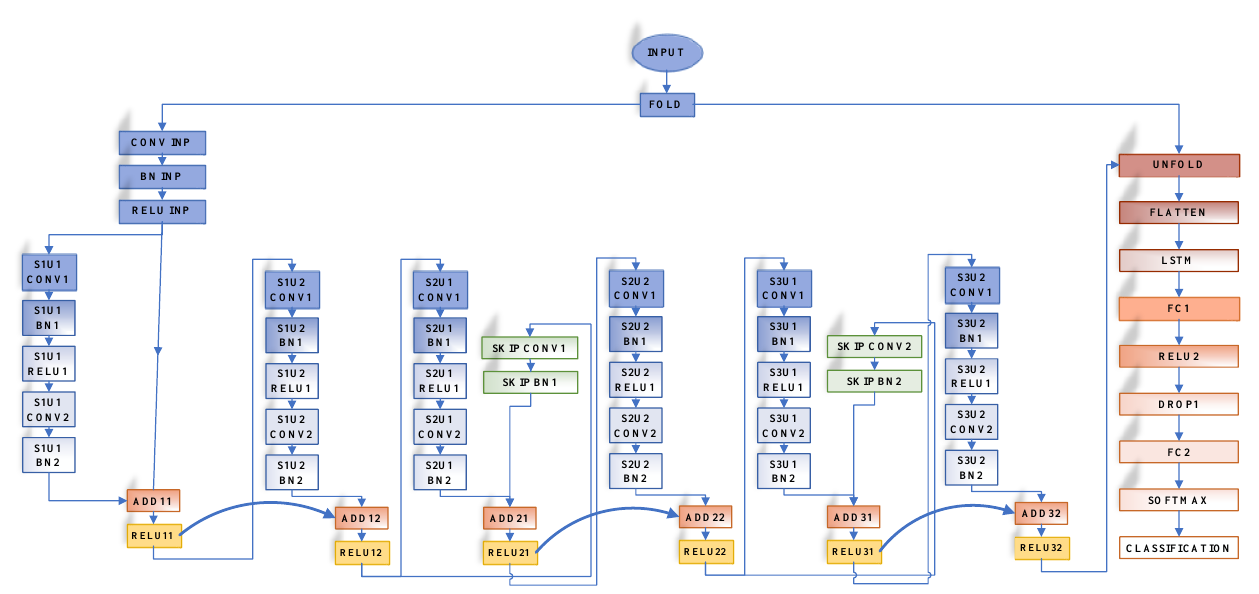
Figure 2. Representation of the proposed R-CNN+LSTM.